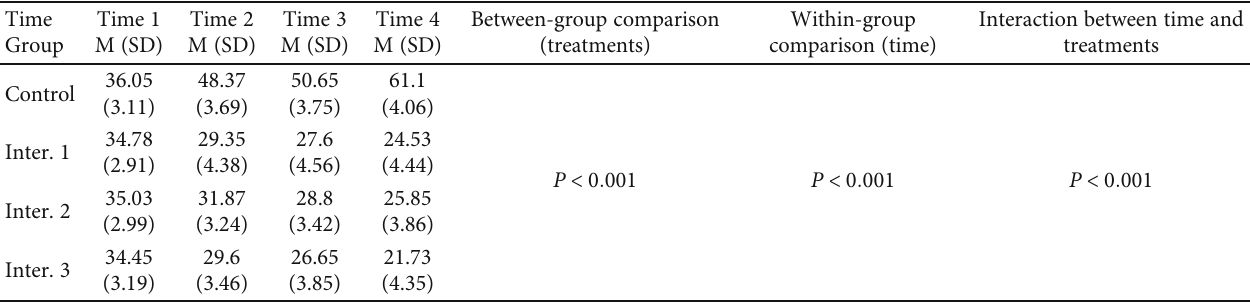
Table 2: Comparisons between trial and control groups in terms of perceived stress at baseline (time 1), 6 months (time 2), 15 months (time 3), and 21 months (time 4) after the